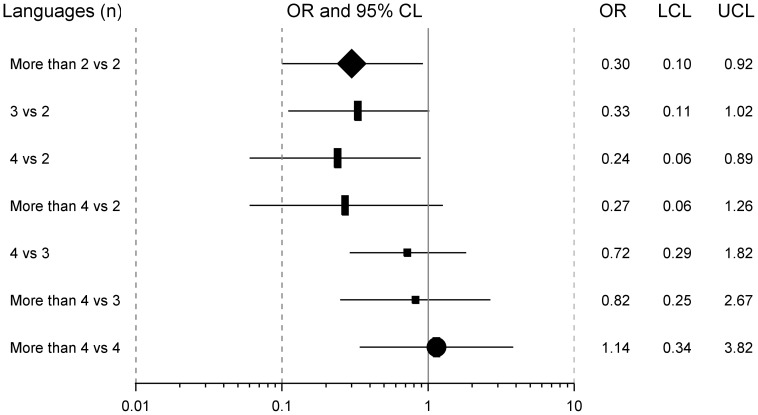
Association between different stages of multilingualism and CIND.Forest plot of the OR comparing different stages of multilingualism over lifetime, to bilingualism, trilingualism and/or quadrilingualism. The solid vertical line shows an OR of 1 (no effect). Each multilingual status is represented by a square, the size of which shows the corresponding sample size in the analysis. The symbols represent the four different analysis performed. The lozenge at the top shows the overall effect of speaking “more than two languages” versus “exactly two languages”. The CL for each situation is represented by a horizontal line and the lower and upper control limits are indicated next (LCL, UCL).